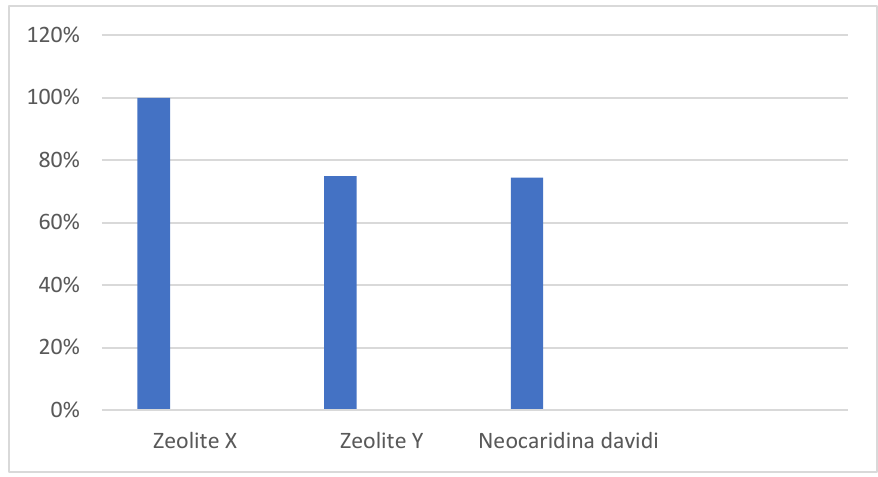
Figure 6. Total percentage representation of Cryptosporidium -positive samples based on the type of filter.